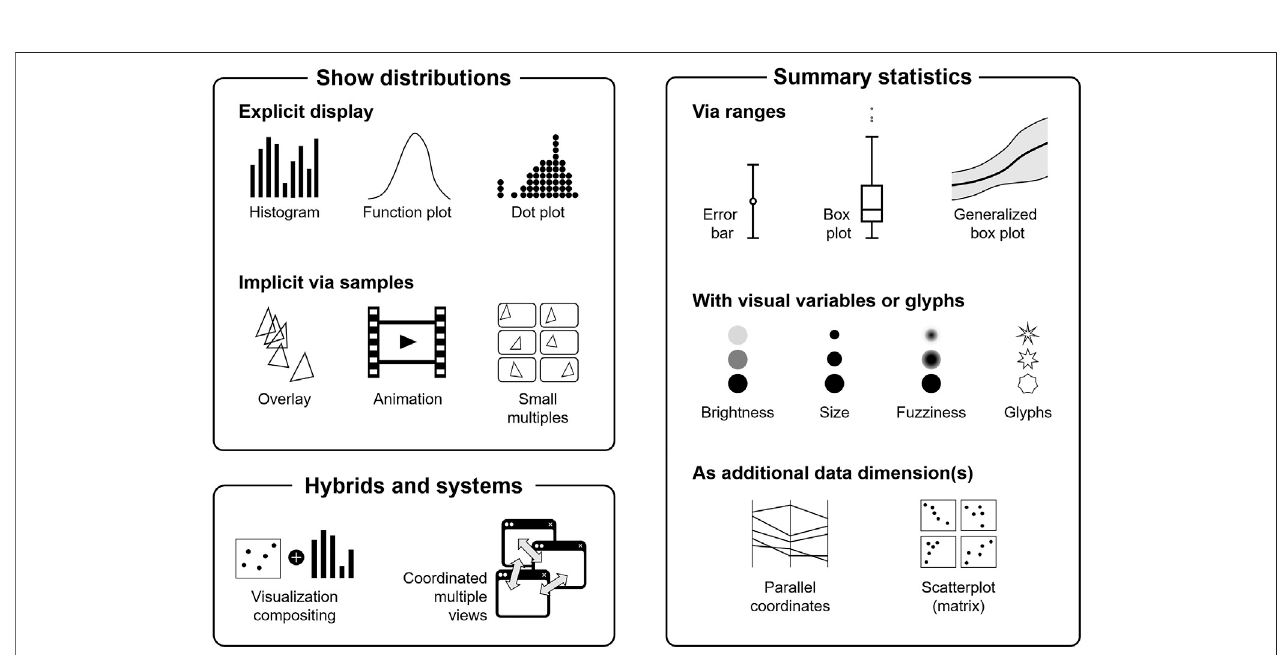
FIGURE4| Overviewofvisualmappingstrategiestoshowuncertainty.Theindividualvisualizationtechniquesonlyserveasillustrativeexamplesandarenot meant to provide a complete list of methods.